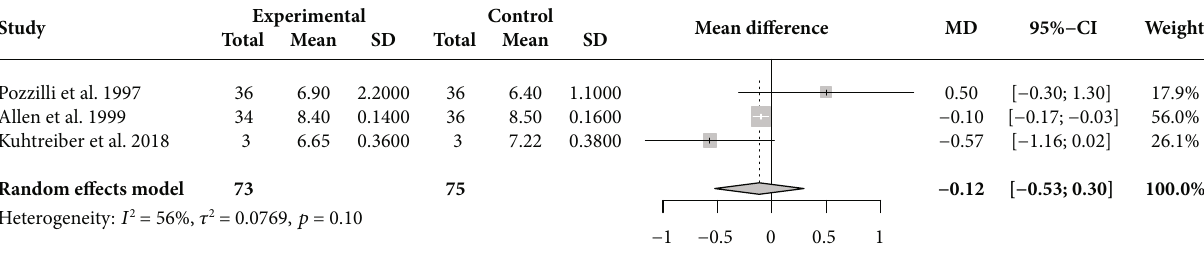
Figure 2: Forest plot of pooled HbA1c level (%) after the intervention (overall meta-analysis). HbA1c: glycated hemoglobin; MD: mean di ff erence; CI: con fi dence interval.